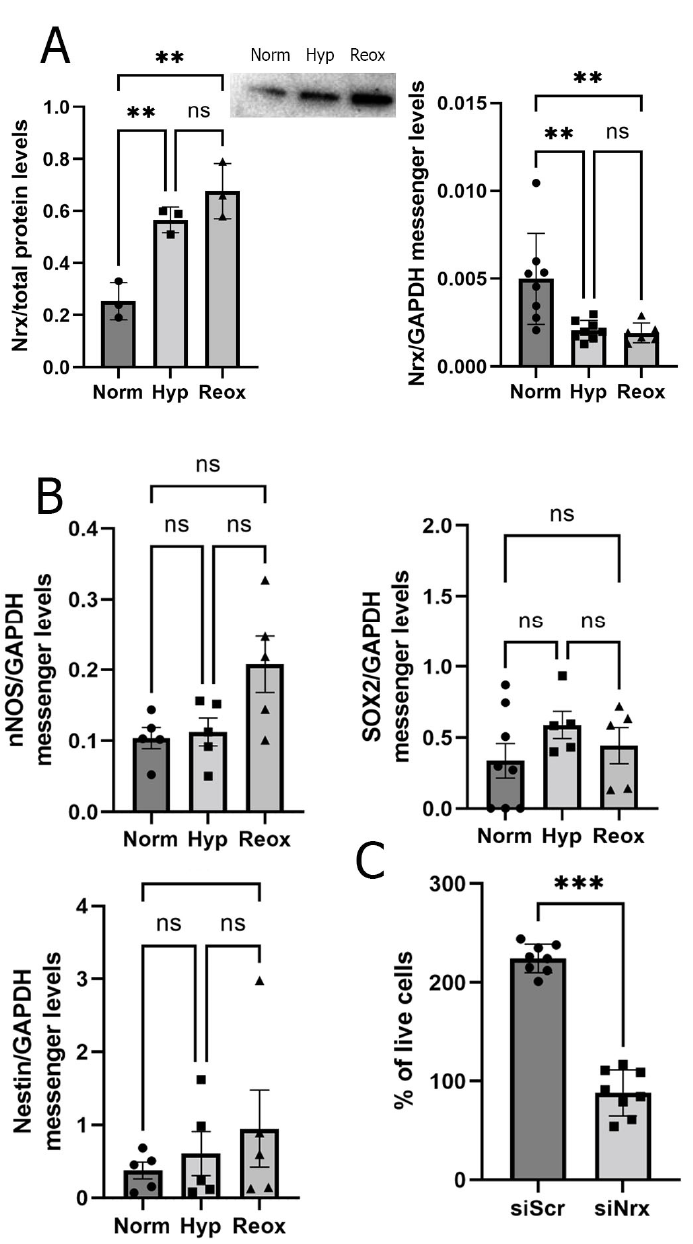
Figure 2. Nrx changes in ARPE-19 cells. ( A ). Nrx protein ( p = 0.0067, 0.0015; n = 3) and mRNA levels in ARPE-19 cells exposed to hypoxia and reoxygenation ( p = 0.0053, 0.0068; n = 6). ( B ). qRT-PCR analysis using differentiation markers (SOX2, Nestin and nNOS) in ARPE-19 cells exposed to hypoxia and reoxygenation ( p = ns; n = 5). ( C ). MTT assay displaying cell proliferation/viability in control ARPE-19 cells (siScr) or cells with transient Nrx knock-down (siNrx) ( p = 0.0002; n = 8). Bars and error bars represent the mean + standard deviation (SD). **, *** Asterisks represent different levels of